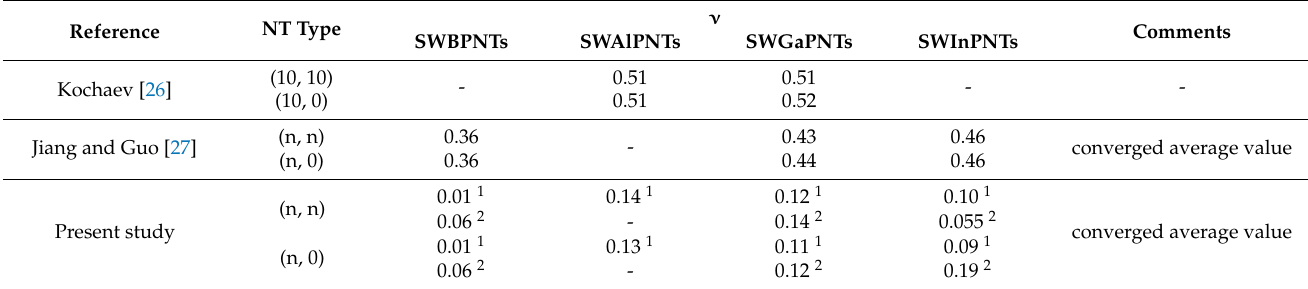
Table 10. Comparison of the current Poisson’s ratio results for phosphide nanotubes with those reported in the literature.